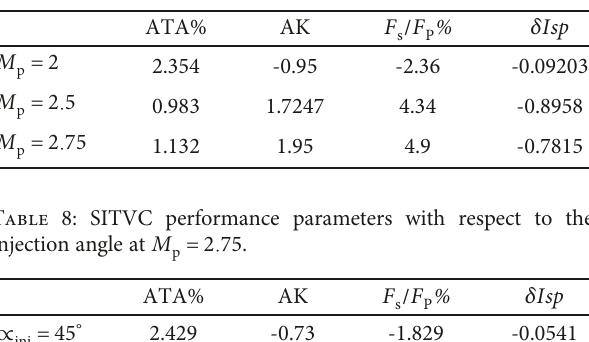
Figure 23: In fl uence of the divergence half angle on injector wall static pressure distribution M = 2 75 . p Table 7: SITVC performance parameters with respect to injection location.